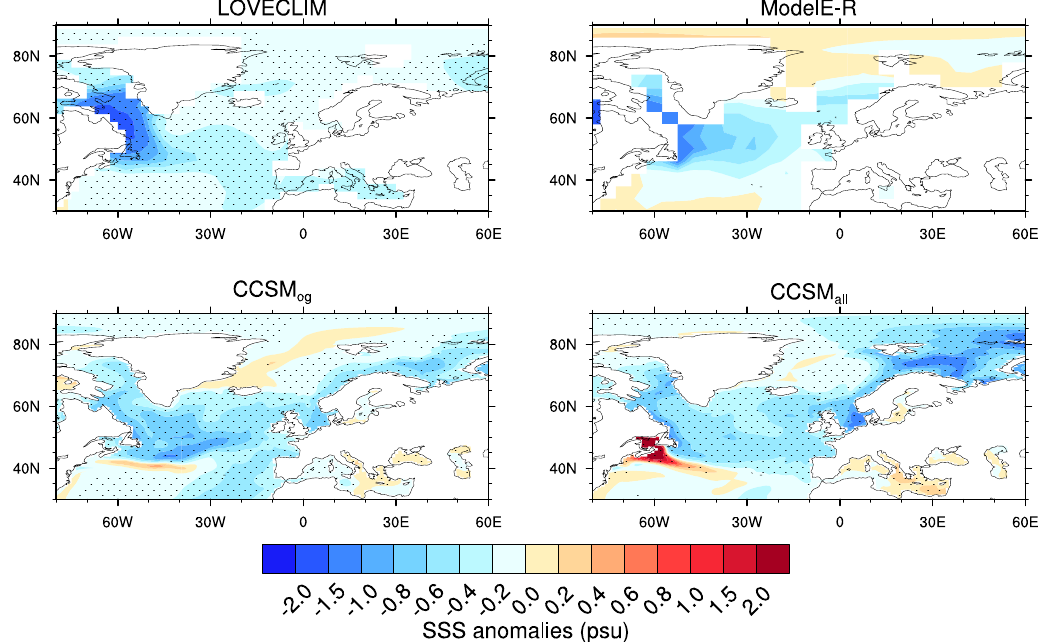
Fig. 4. Anomalies of annual-mean sea surface salinity in the first fifty years following the MWP relative to the control simulation, in practical salinity units. Stippling shows statistical significance at the 95% level according to a Student’s t test. Statistical tests were not performed for ModelE-R since only decadal averages were available.